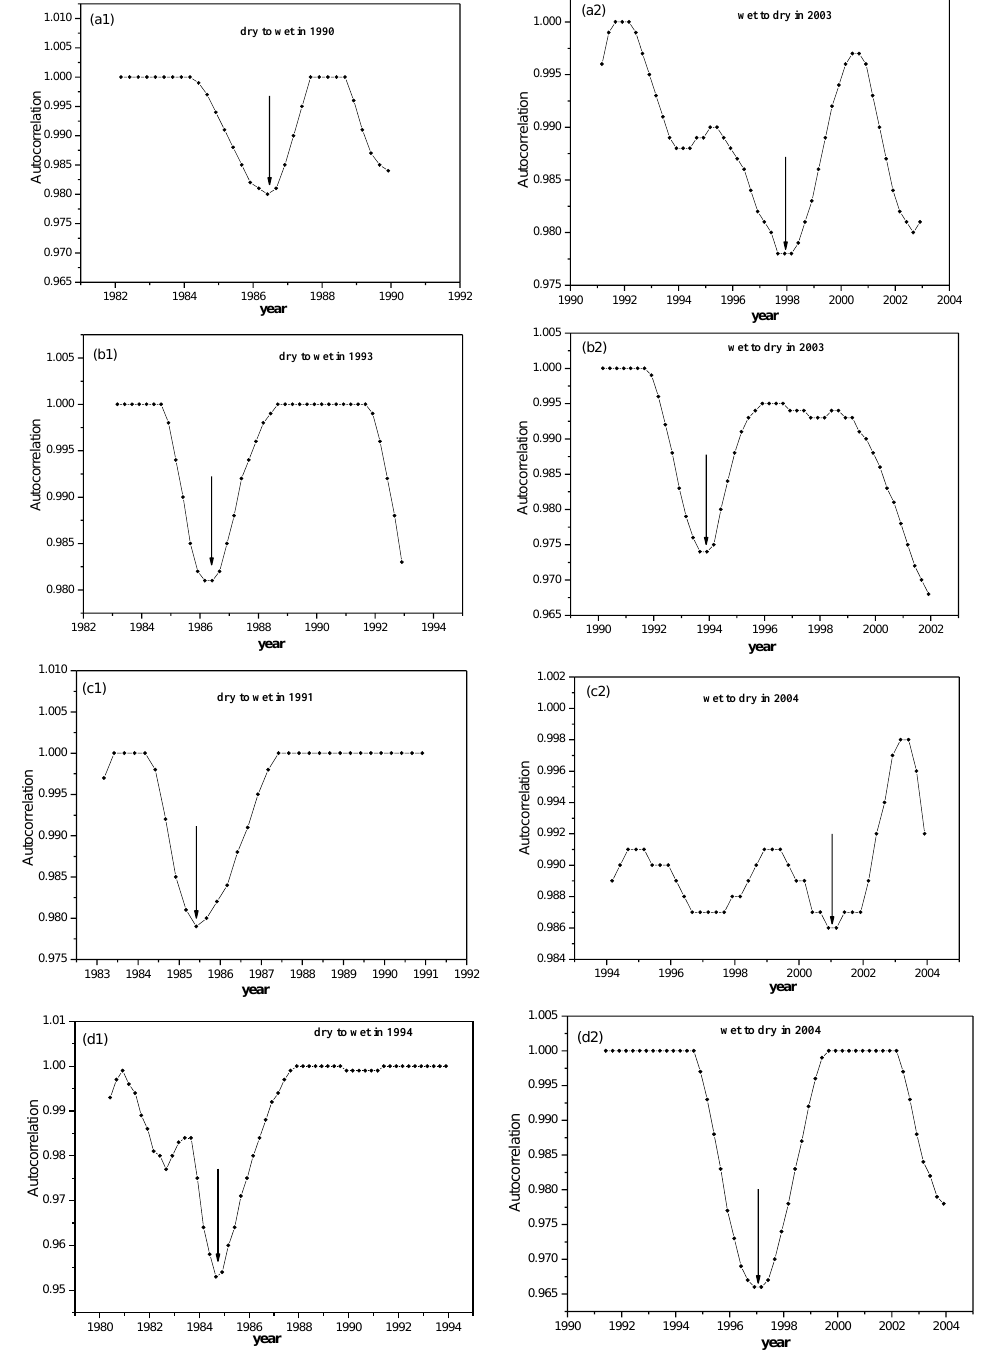
Figure 6. Auto-correlation coefficient signal-based detection of DWT in different sub-regions of the two-lake region. The ML is set to 10 years, the MT is set to 3 months, and the LT is set to 1 month for the sliding window. ( a1 – d2 ) correspond to the four sub-regions. The left and right figures correspond to the two DWT events in the early 1990s and early 2000s, respectively.